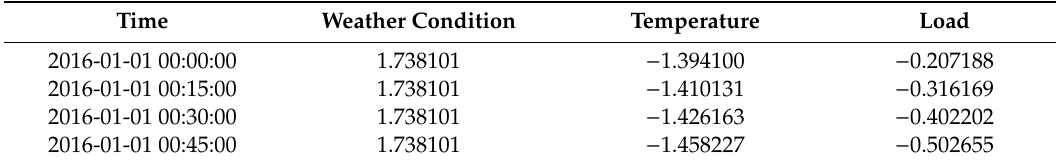
Table 3. Data display in the first 5 rows of the pre-processed data table.